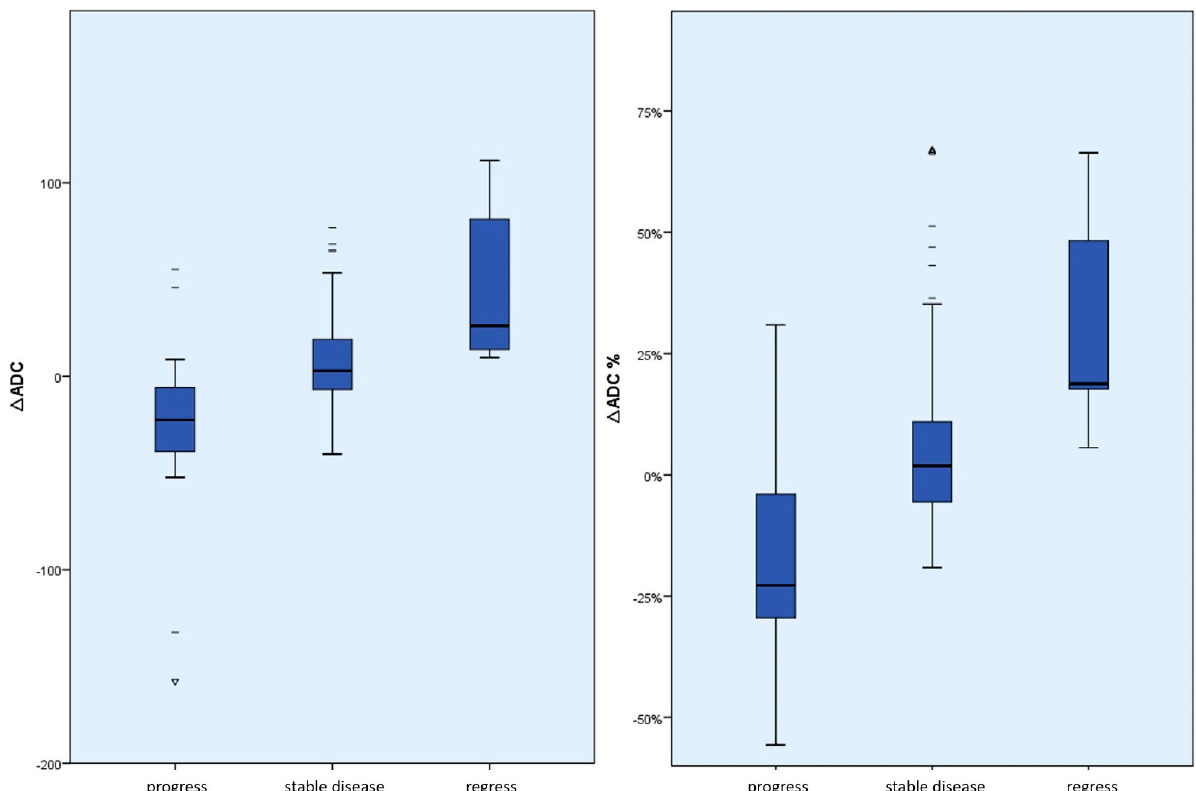
Figure 4. Box plot of the absolute or percentage ∆ ADC values according to the course of the disease. This shows an absolute and relative ADC increase in tumor regression compared to stable disease and tumor progression or an absolute and relative ADC decrease in tumor progression compared to stable disease and tumor regression. In particular, there were no negative ∆ ADC values in the case of tumor regression. (dashes = mild outliers; triangles = extreme outliers).